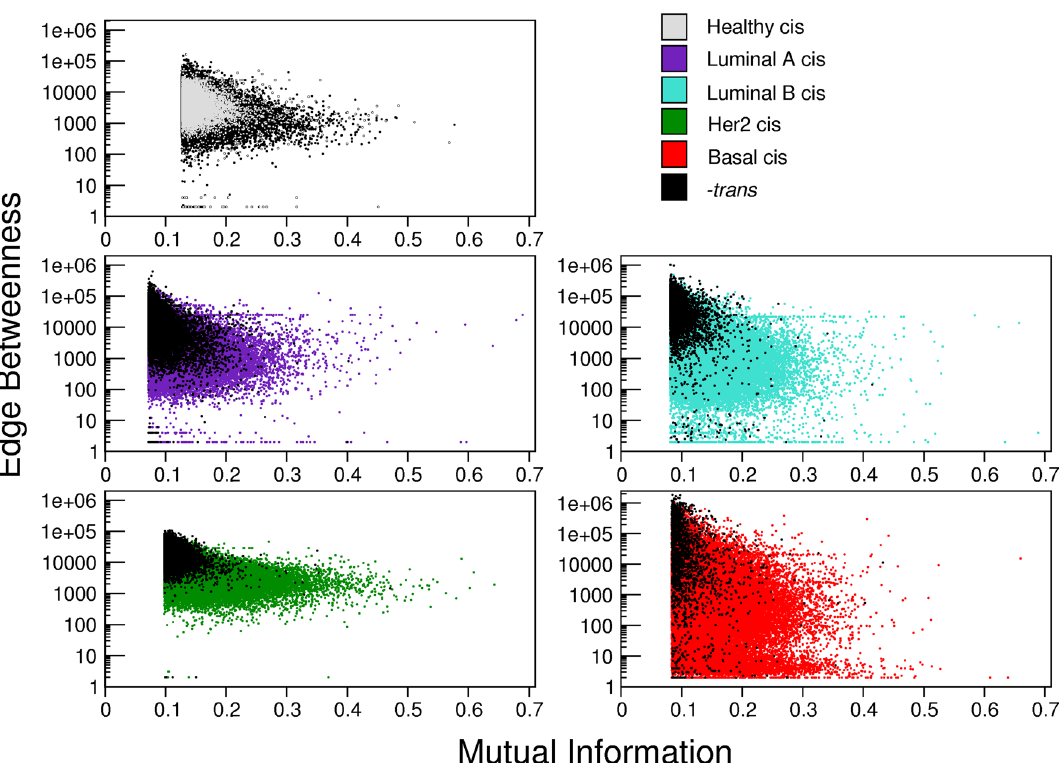
Figure 2. Scatterplots of co-expression mutual information (MI) values vs. Edge Betweenness (EB). In this representation, colored dots represent cis- interactions for each breast cancer subtype, as well as for healthy network. Black dots show trans- interactions for any phenotype. Notice that for cancer scatterplots black dots appear in the highest EB values (Y-axis), meanwhile colored points are somehow homogeneously